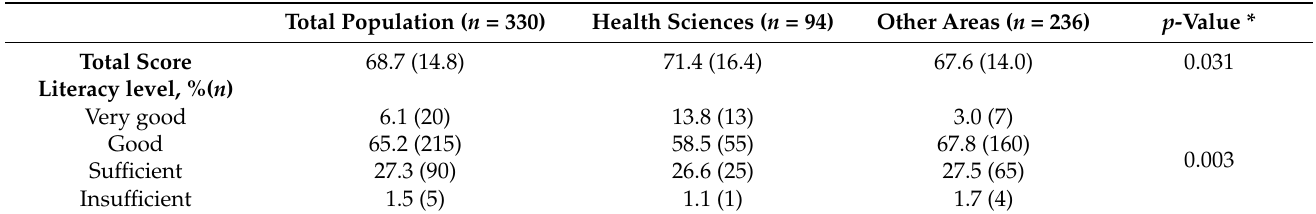
Table 3. The literacy level of the population studied according to the professional area.